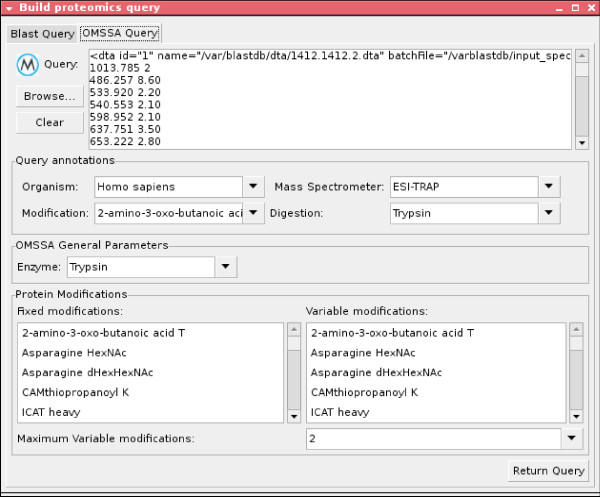
GUI for building OMSSA queries.